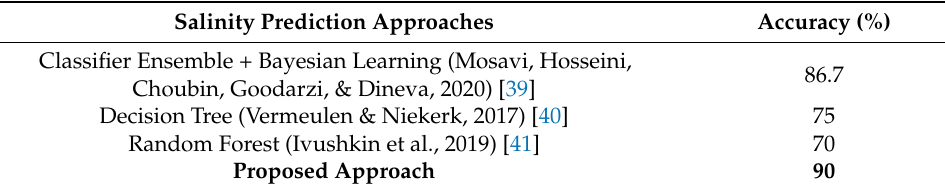
Table 6. Comparison of various salinity based classification approaches. Salinity Prediction Approaches Accuracy (%) Classifier Ensemble + Bayesian Learning (Mosavi, Hosseini, Choubin, Goodarzi, & Dineva, 2020)